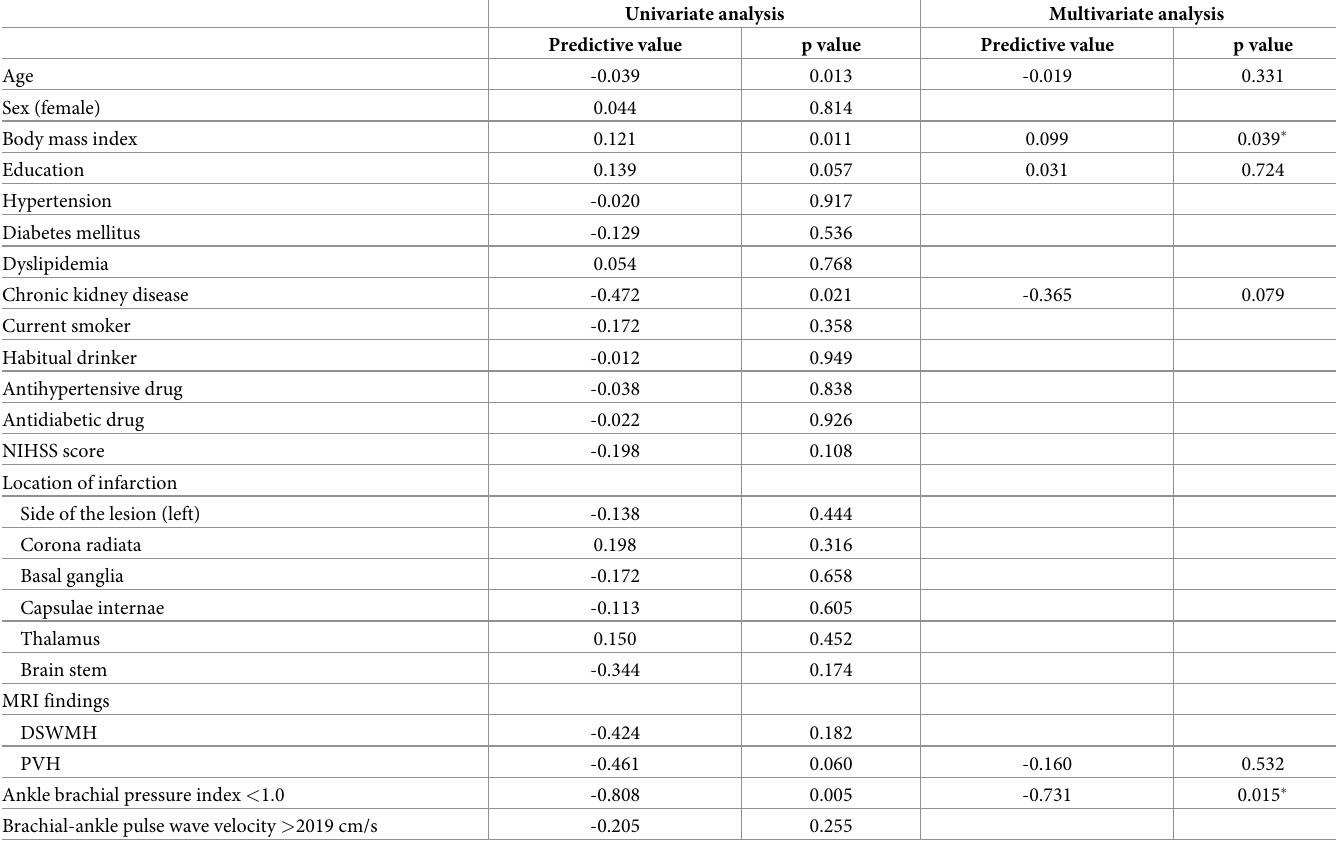
Table 2. Associations between multiple factors and decrease in MMSE scores.